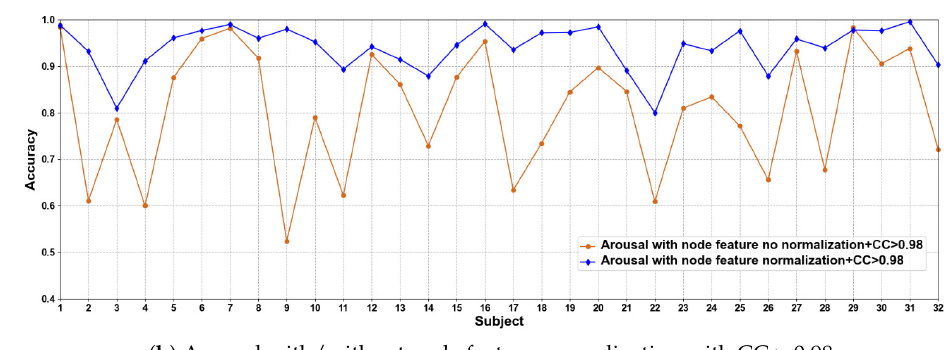
Figure 4. Classification accuracies on each subject on arousal with/without normalization.